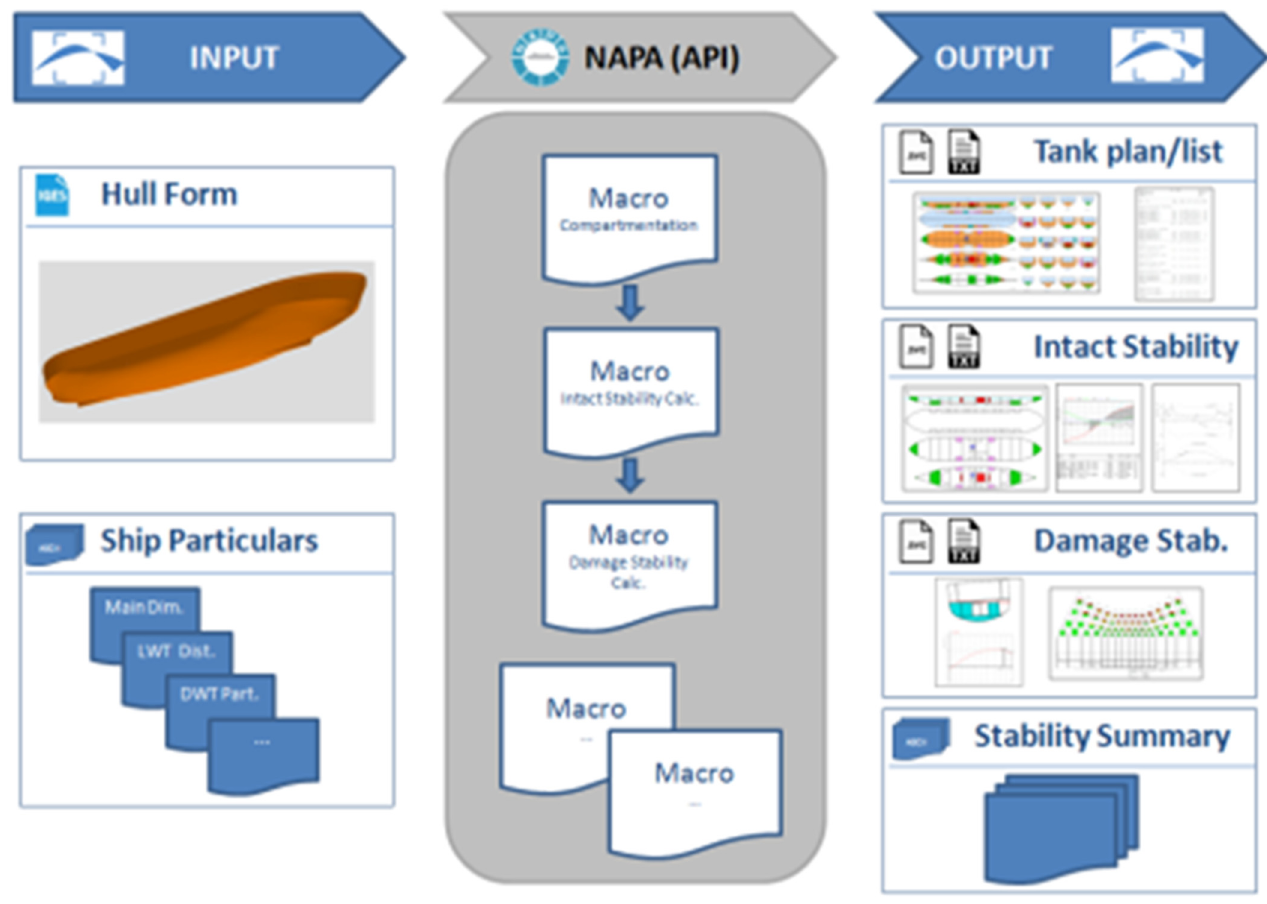
Figure 2. HOLISHIP Collaborating platforms CAESES and NAPA. Intact and damage stability determined by NAPA; pre- and postprocessing conducted by CAESES, NTUA & Hochschule Bremen (HSB) [7].